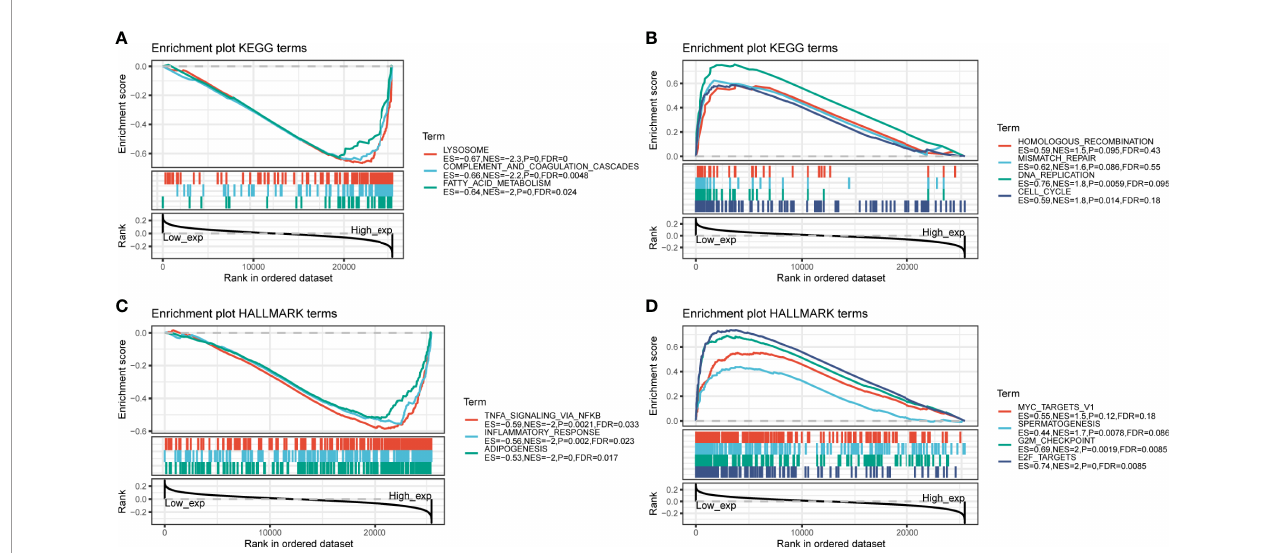
FIGURE 4 | GSEA analysis of C5AR2 related to signaling pathways and biological states or processes in KEGG and hallmark datasets. (A) The top three rankings of signaling pathways in the KEGG dataset by samples of high C5AR2 expression. (B) The top three rankings of signaling pathways in the KEGG dataset with the low C5AR2 expression. (C) The top three rankings of signaling pathways in the hallmark dataset by the high C5AR2 expression sample. (D) The top three rankings of signaling pathways in the hallmark dataset with low